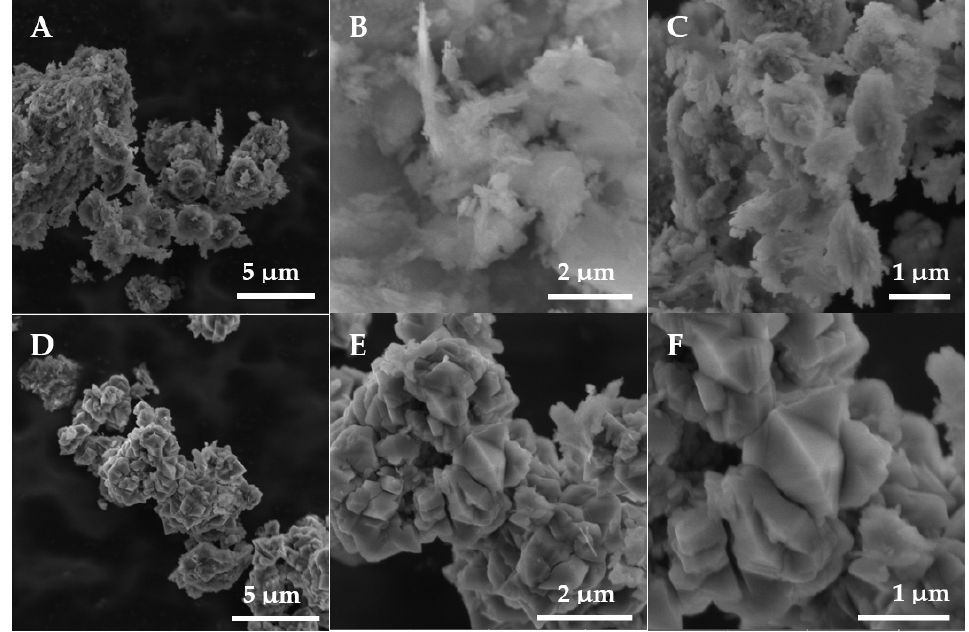
Figure 5. Micrographs of the clinoptilolite samples: ( A ) 5 µm scale, ( B ) 2 µm scale, and ( C ) 1 µm scale. Micrographs of GISC4d: ( D ) 5 µm scale, ( E ) 2 µm scale, and ( F ) 1 µm scale.